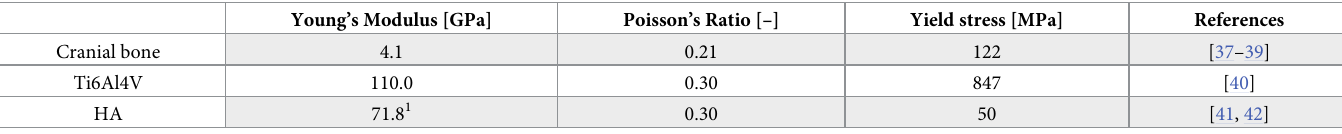
Table 1. Mechanical properties of the used